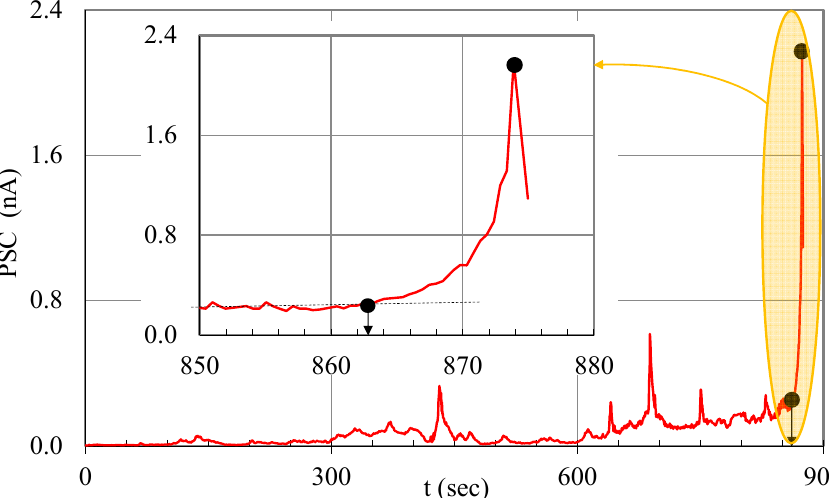
Figure 14. The temporal evolution of the PSC recorded during the experiment with mutually interconnected marble blocks under pure shear, that was discussed in Section 3.4.